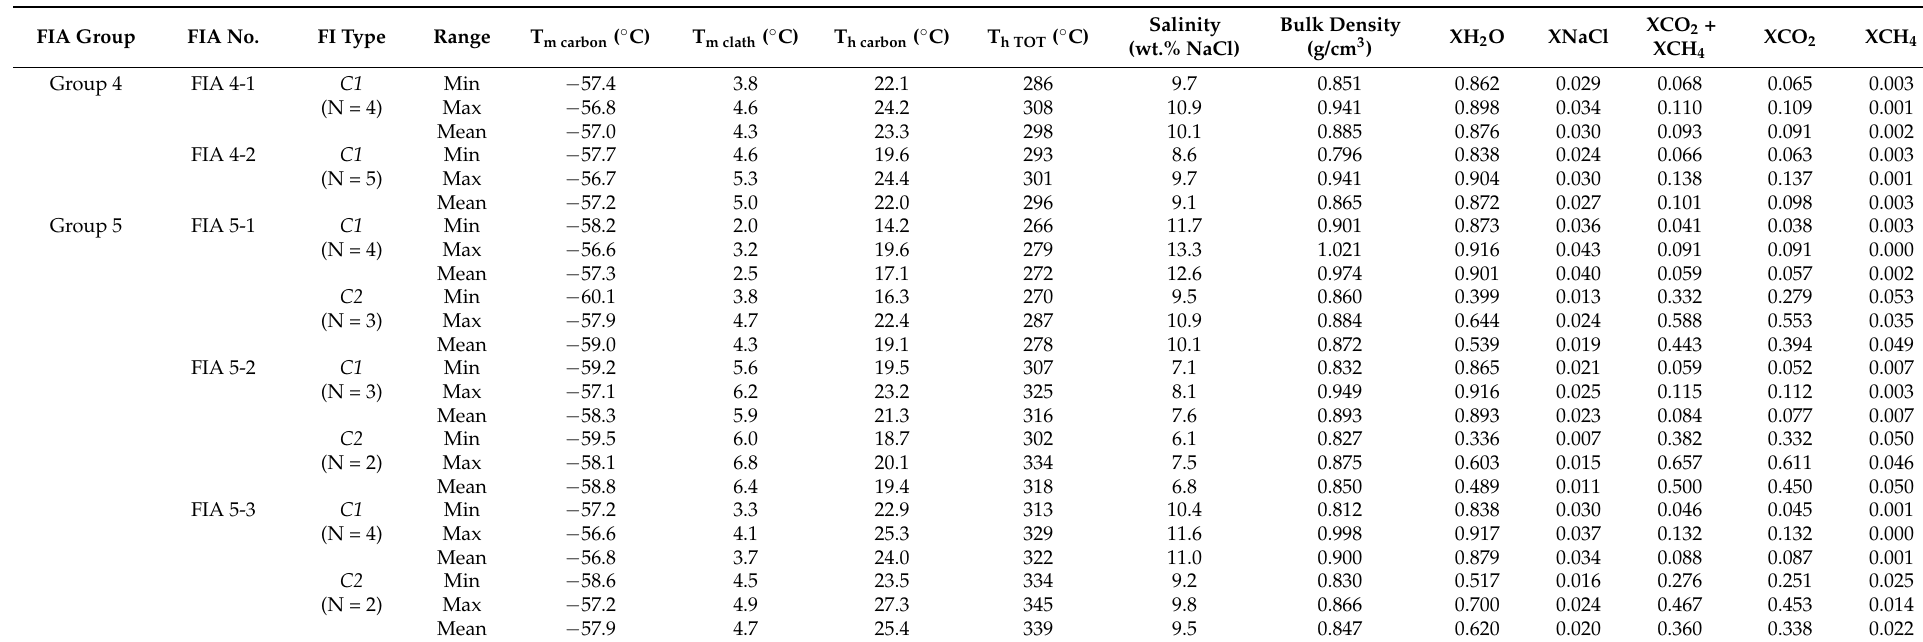
Table 4. Summary of the microthermometric data and calculated parameters for Groups 4 and 5 FIAs from stage III